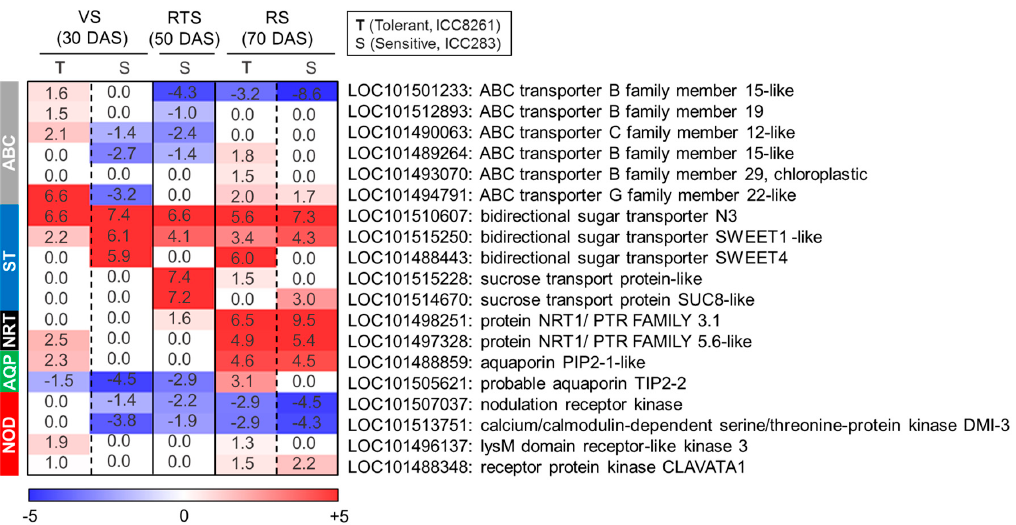
Figure 6. Heatmap illustrating differential expression of various transporters and root-nodule development genes that include ABC-transporters (ABC), sugar transporters (ST), NRT1/PTR transporter family (NRT1/PTR), aquaporins (AQP) and nodulation related genes (NOD) in the tolerant (T, ICC8261) and sensitive genotype (S, ICC283) at vegetative (VS), reproductive transition (RTS) and reproductive (RS) stages. The scale color represents log2 fold change.